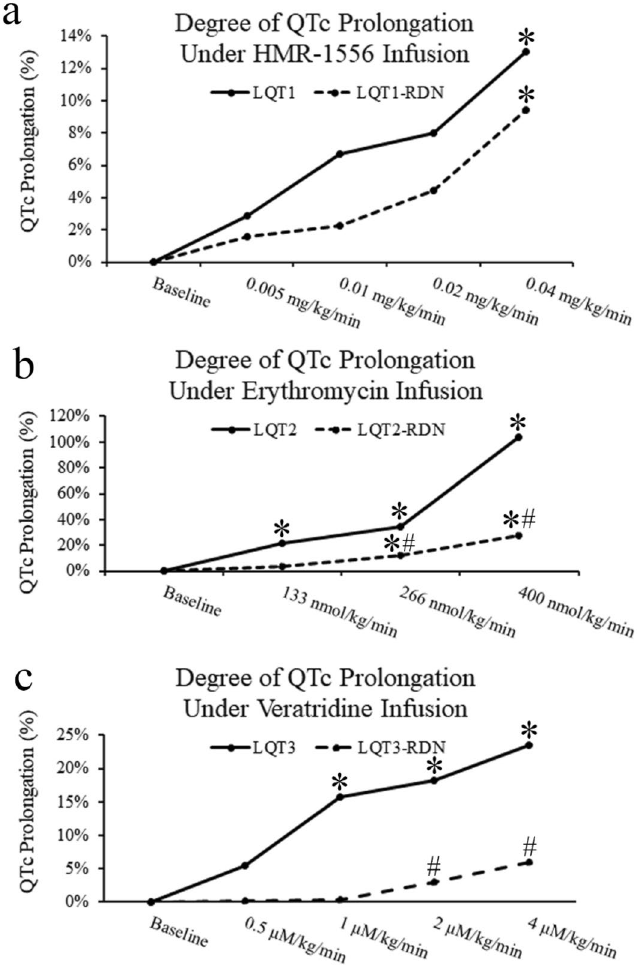
Figure 3. Degree of QTc interval prolongation under LQTS induction. ( a ) QTc prolongation of the LQT1 and LQT1-RDN groups under sequential HMR-1556 infusion. ( b ) QTc prolongation of the LQT2 and LQT2-RDN groups under sequential erythromycin infusion. ( c ) QTc prolongation of the LQ3 and LQT3-RDN groups under sequential veratridine infusion. (* p < 0.05 compared with baseline within the same group. # p < 0.05 compared between LQT and LQT-RDN groups under the same concentration of LQTS drug